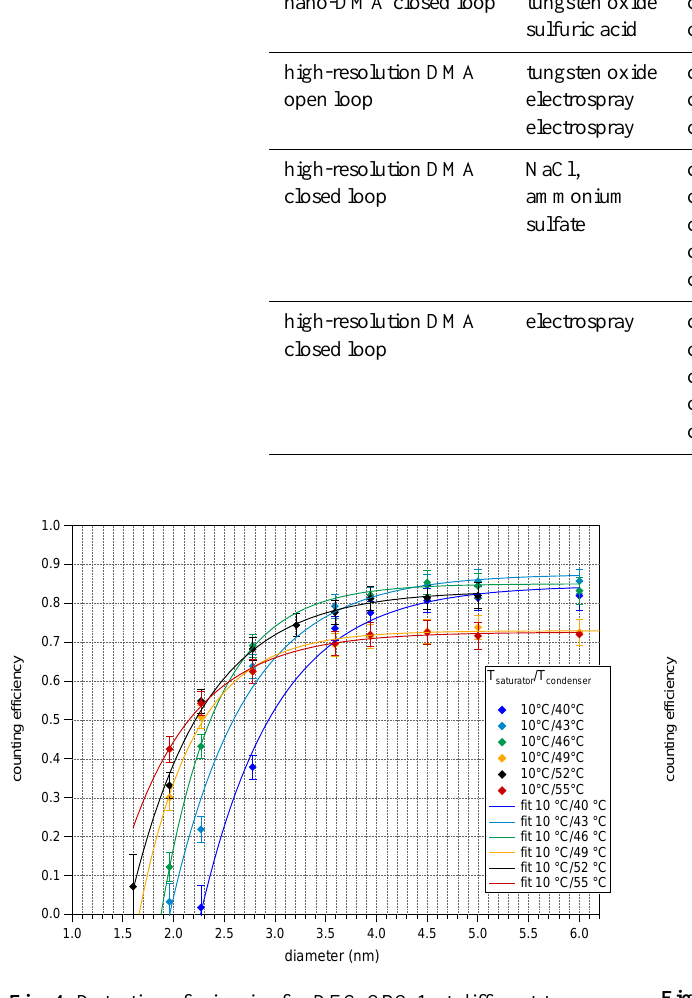
Fig. 4. Detection efficiencies for DEG CPC 1 at different temper- ature settings, using tungsten oxide particles. The condenser tem- perature was 10 ◦ C, and the saturator temperature was varied from 40 ◦ C (blue) up to 55 ◦ C (red). The black symbols show the setting of 52 ◦ C, which was used throughout all the experiments shown in this work. The fit curves to the data are based on the parameteriza- tion by Stolzenburg and McMurry (1991).